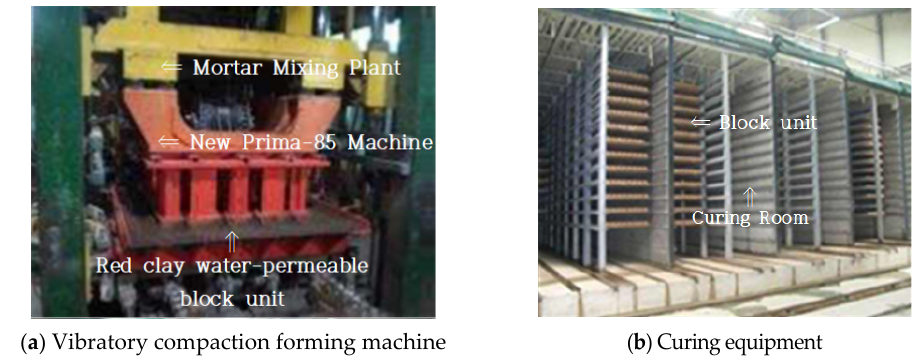
Figure 3. Unit structure forming and curing equipment.